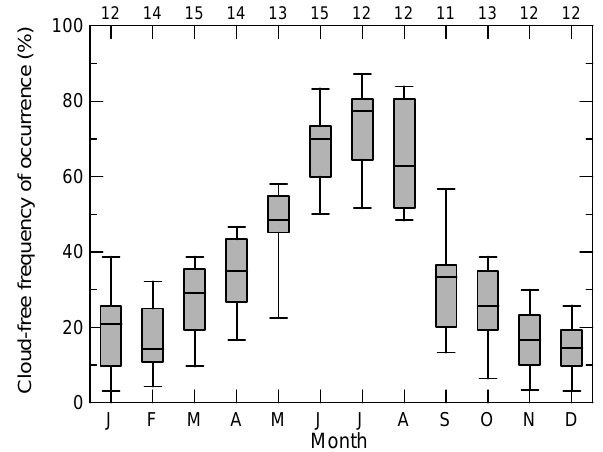
Figure 4. Monthly statistics of the fraction of cloud-free sky be- tween 09:00 and 14:00UTC. Only months with at least 27 days with measurements in the period 2002–2016 are considered. Minimum, lower quartile, median, upper quartile, and maximum are indicated (from the bottom to the top) for each month. The number of monthly mean values used for each month is displayed above the top axis.